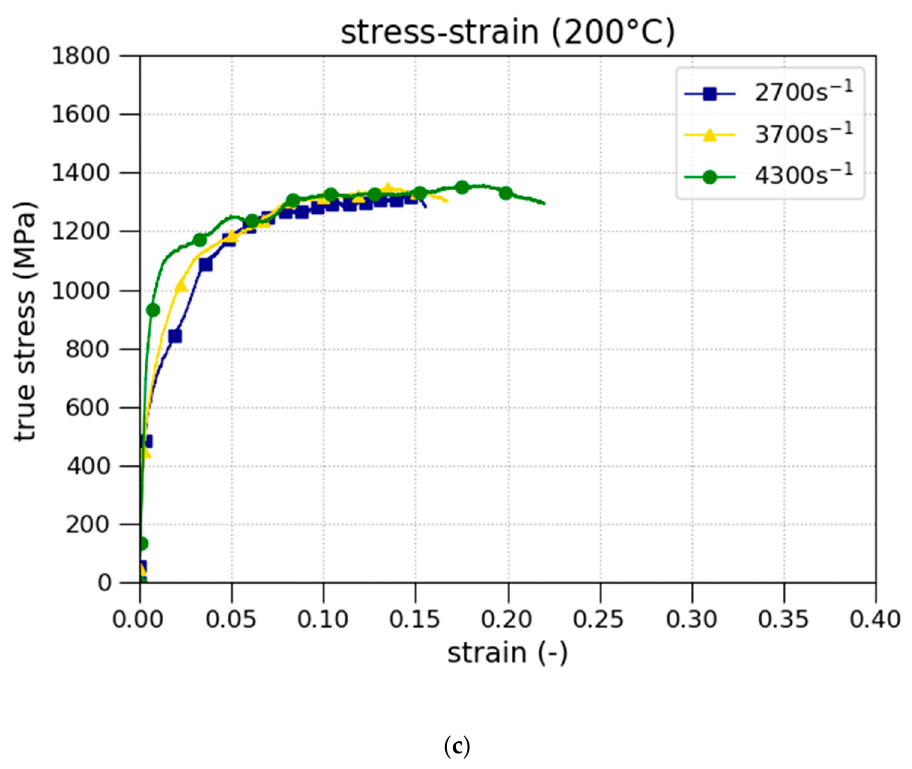
Figure 5. True stress–strain curves at: ( a ) room temperature; ( b ) 100 °C; ( c ) 200 °C .